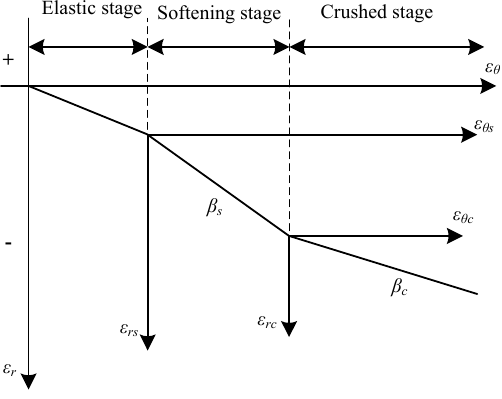
Figure 4. Dilation model of rock mass.